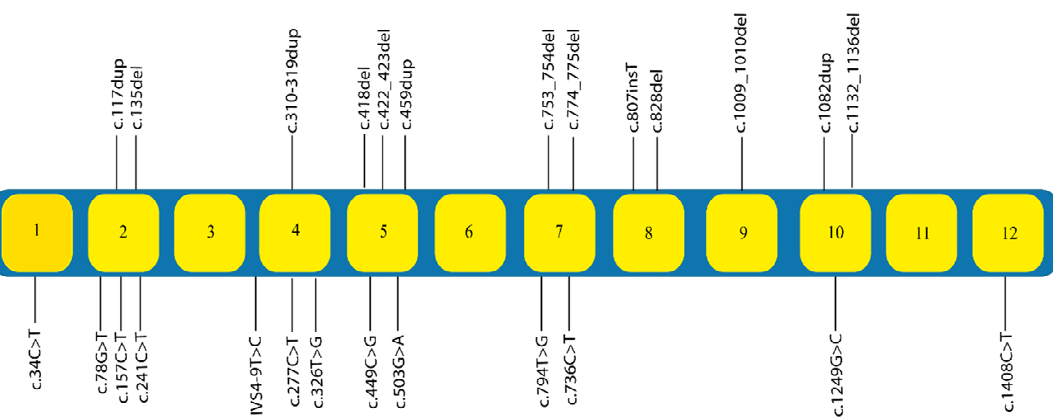
Figure 6. Schematic presentation of variants in CHRNG gene associated with Escobar syndrome (according to the literature).